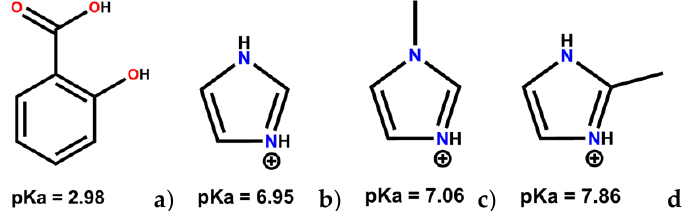
Figure 1. Molecular representation of protonated ( a ) SA; ( b ) IMI; ( c ) 1-MEIM and ( d ) 2-MEIM with their pKa values.